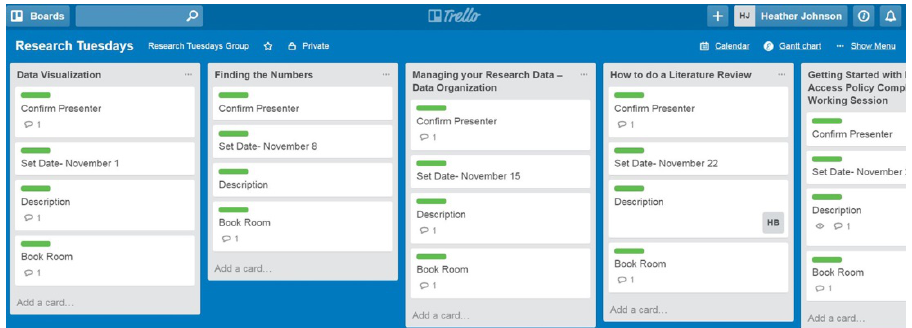
Figure 1: Sample Trello lists and